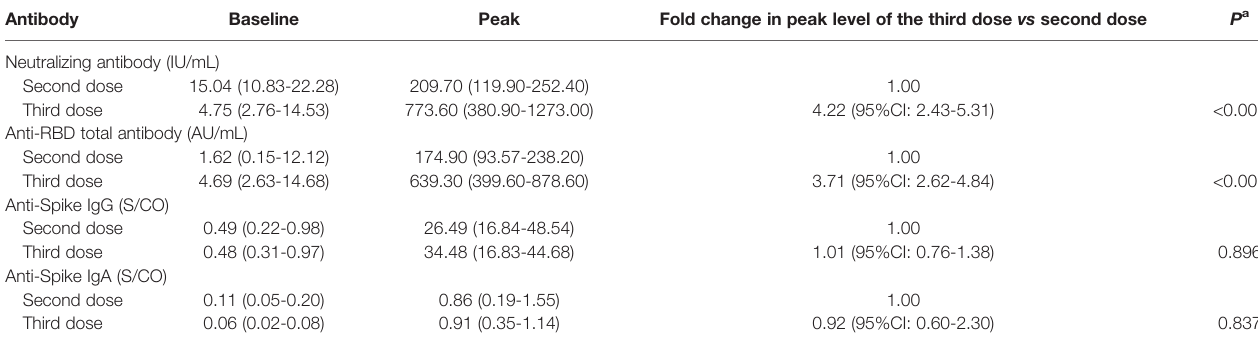
TABLE 4 | Longitudinal antibodies fl uctuation between the second and third doses. Antibody Baseline Neutralizing antibody (IU/mL) Second